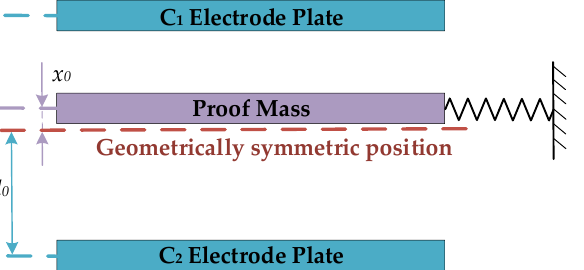
Figure 2. Simplified model of the capacitive micro-accelerometer.